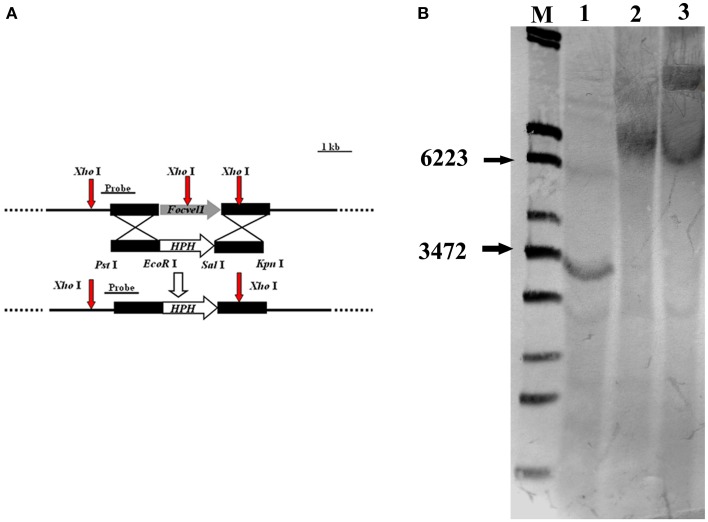
Schematic representation of the FocVel1 deletion strategy. (A)
FocVel1 and hygromycin-resistance (hph) cassettes are denoted by large gray and white arrows, respectively. Red arrows represent the restriction enzyme sites of XhoI. (B) Southern blot hybridization analysis. M, λ-EcoT14 I digest; lane 1, genomic DNA preparations of the wildtype strain (Foc-GD); lane 2, the FocVel1 deletion mutant (ΔFocVel1-3); lane 3, the complement strain (ΔFocVel1-3C).